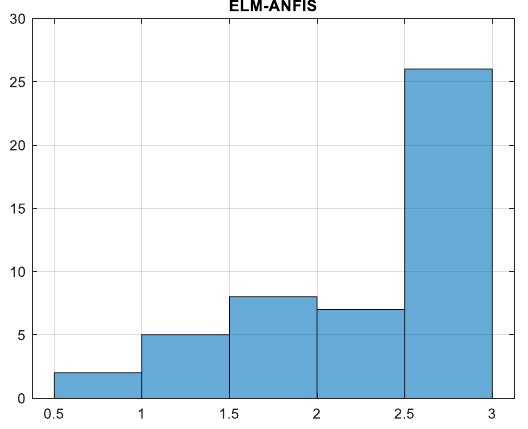
Figure 13. Error distribution of data.